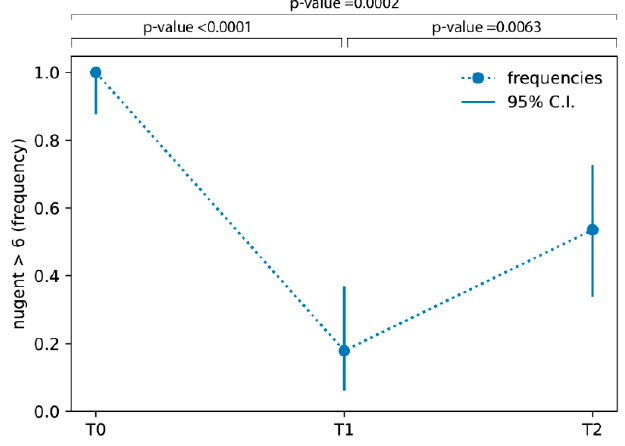
Figure 2. Frequency of positivity of Amsel criteria at T0 (baseline), T1 (15 days after the start of treatment (T1), and T2 (7 days after the end of treatment) sampling times.